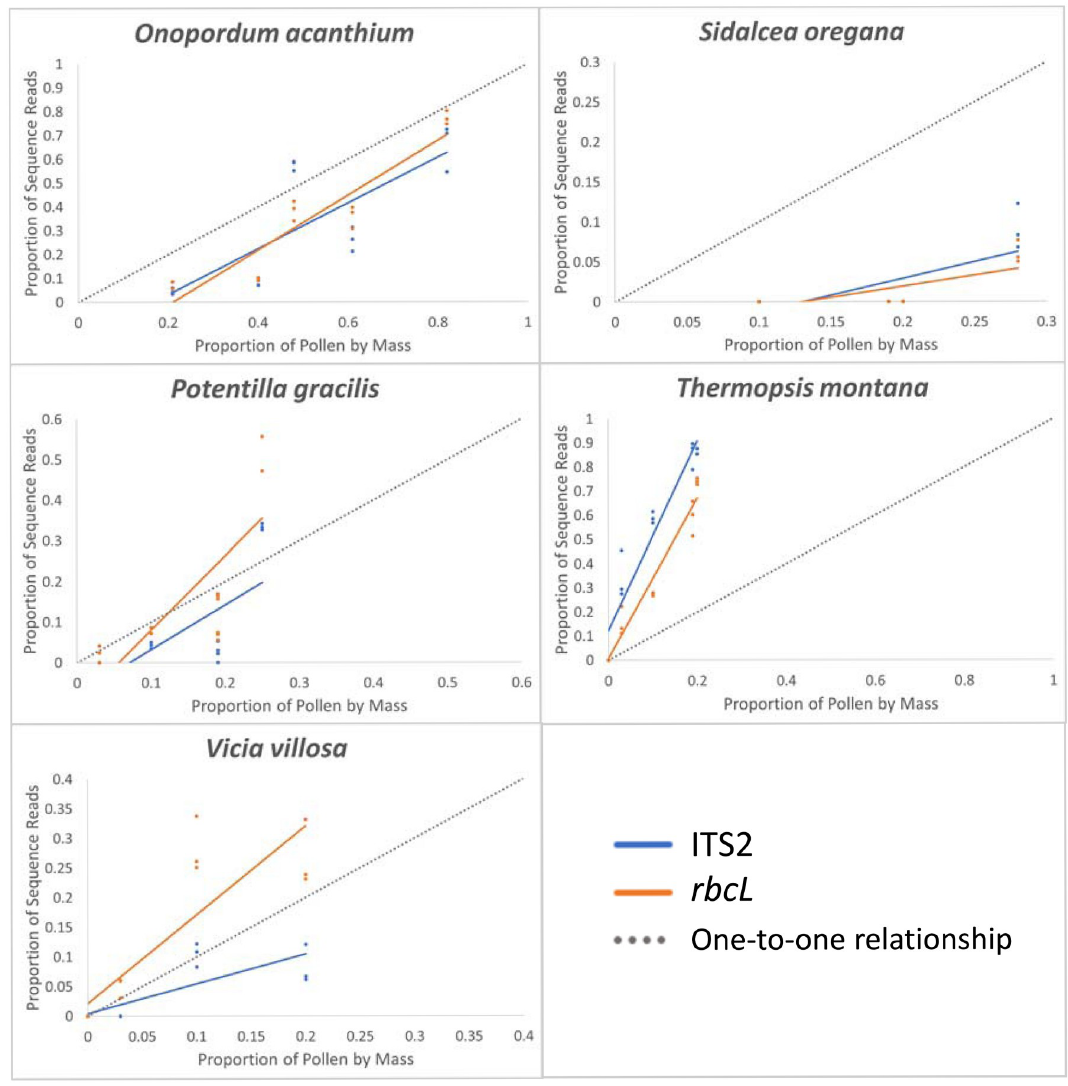
Fig 2. Proportion of pollen by mass in mixtures vs. proportion of sequence reads using the conservative threshold. Gray dotted line represents expected one-to-one relationship. For ITS2, Potentilla gracilis = Potentilla sp.; Thermopsis montana = Thermopsis rhombifolia . For rbcL , Onopordum acanthium = Hieracium sp.; Sidalcea oregana = Malva neglecta ; Potentilla gracilis = Potentilla sp.; Thermopsis montana = Thermopsis sp. See scatterplots in S1 Fig for liberal threshold results.